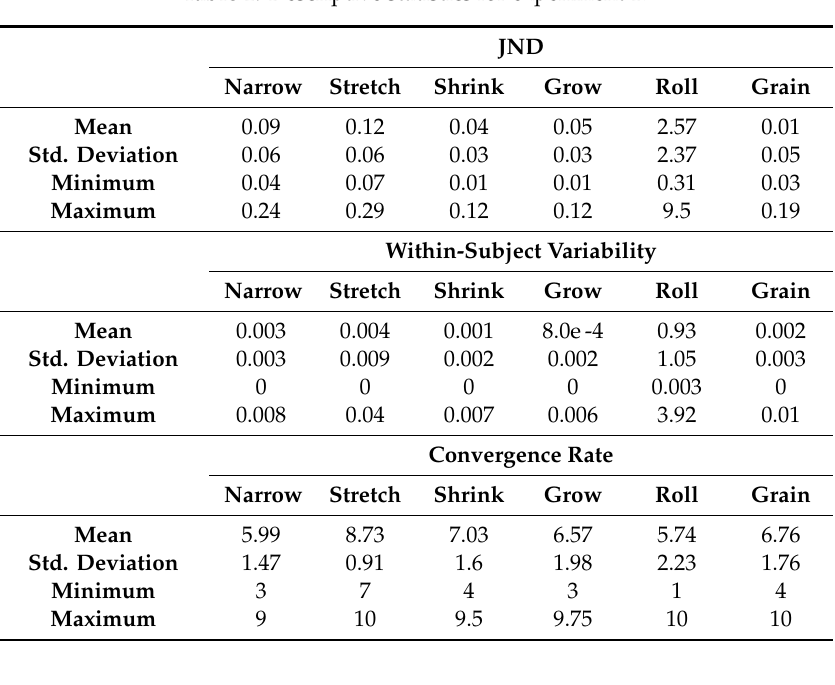
Table 1. Descriptive statistics for experiment